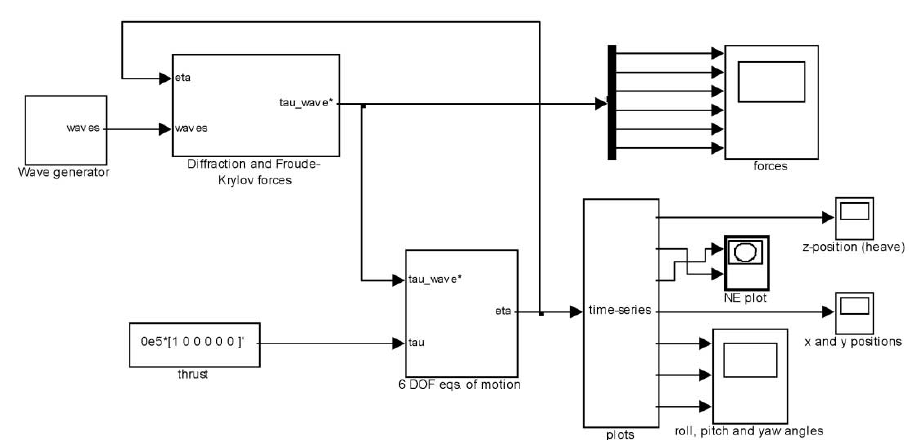
Figure 4. Marine Systems Simulator (MSS): 6 DOF equations of motion including wave excitation forces represented in Simulink for real-time simulation. The data file Forces _ TF . dat is used as input for the Simulink program shown in Figure 4 while the file ABC . mat must be manually loaded into work space. The numerical recipes used in the postprocessing of the data are described in Section